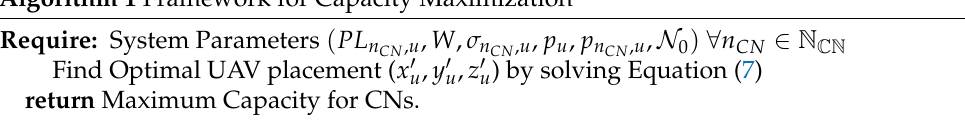
Algorithm 1 Framework for Capacity